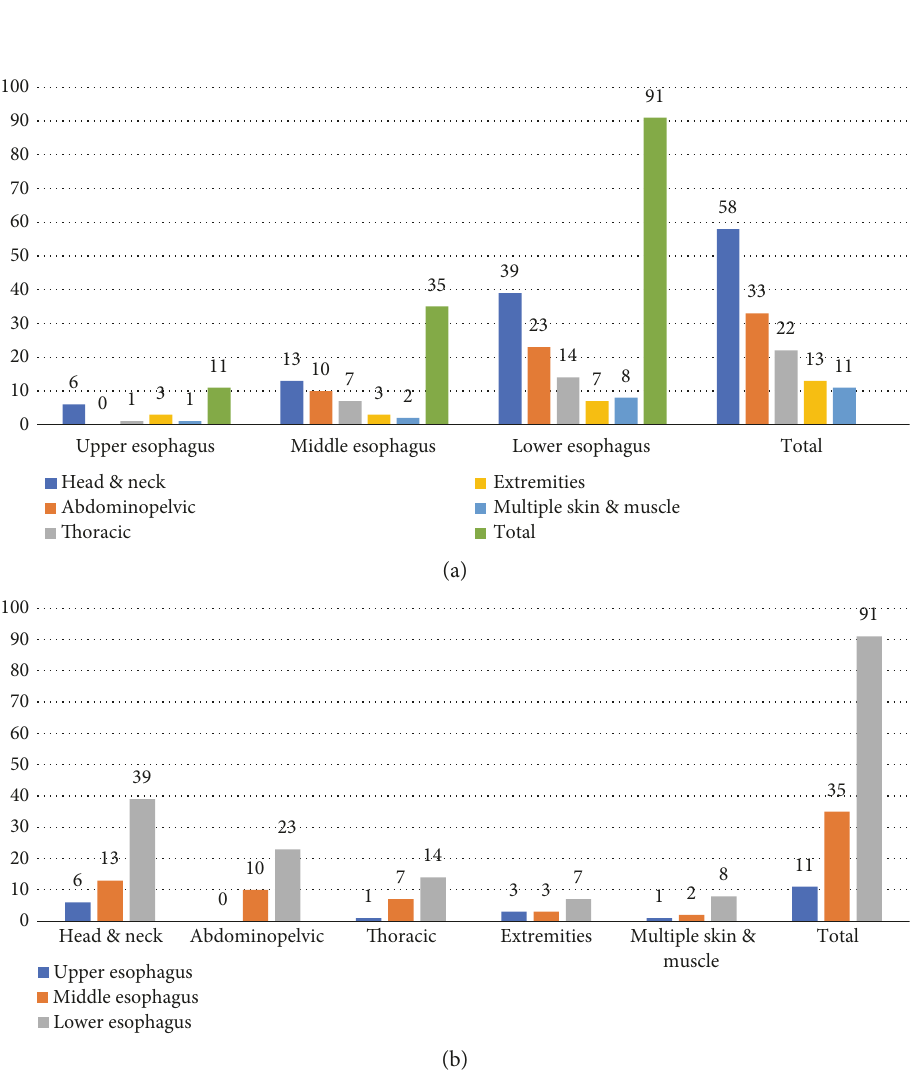
Figure 4: (a) Primary EC location in fl uence on metastasis distribution. (b) Metastasis trend according to primary EC